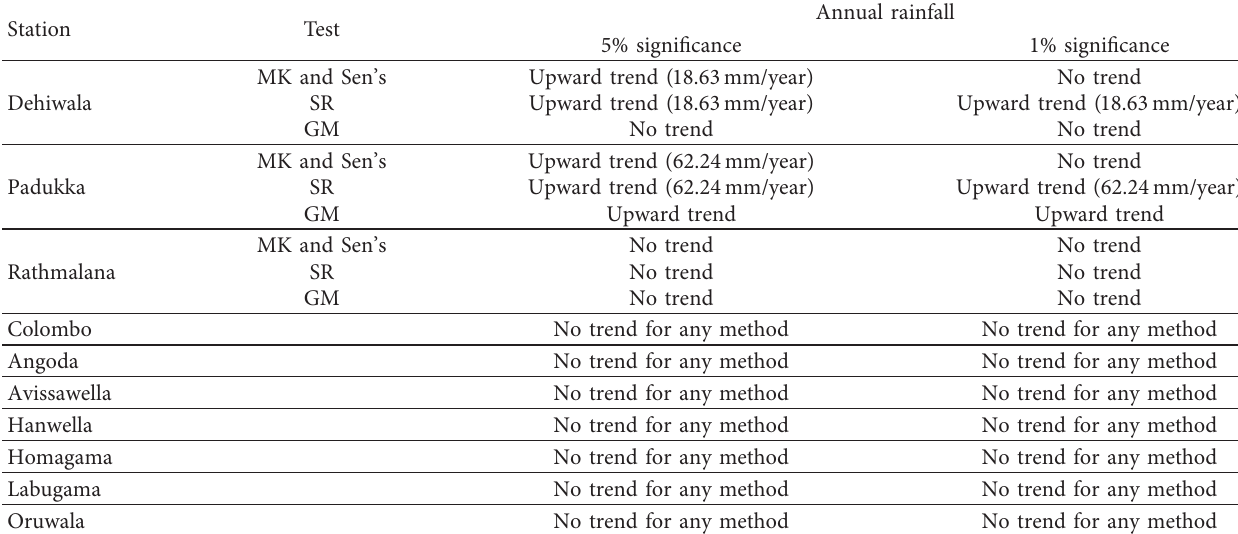
Table 2: Trend analysis results for annual